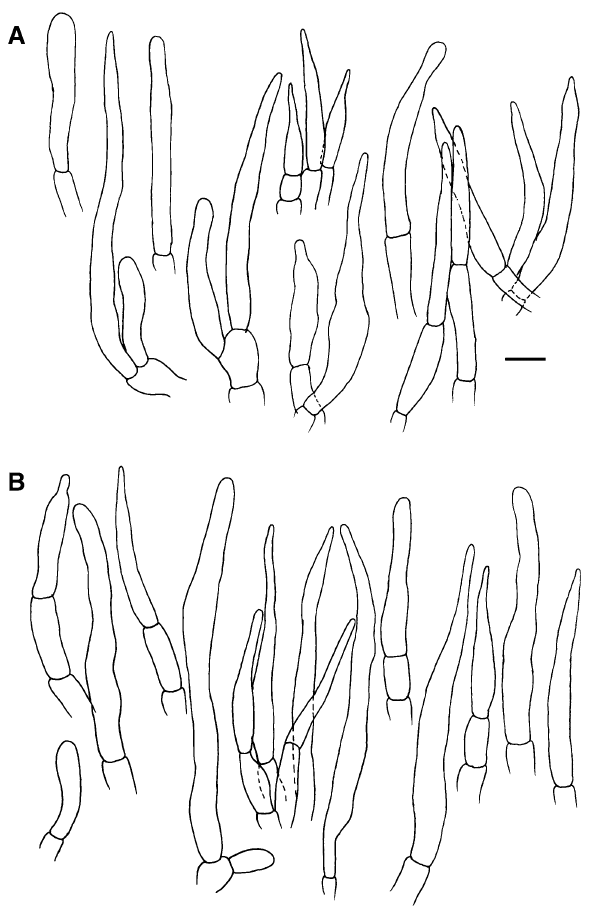
Figure 10. Elements of the pileipellis of Russula luteonana (holotype, BBH41120). ( A ) Hyphal terminations near the pileus margin. ( B ) Hyphal terminations near the pileus centre. Scale bar = 10